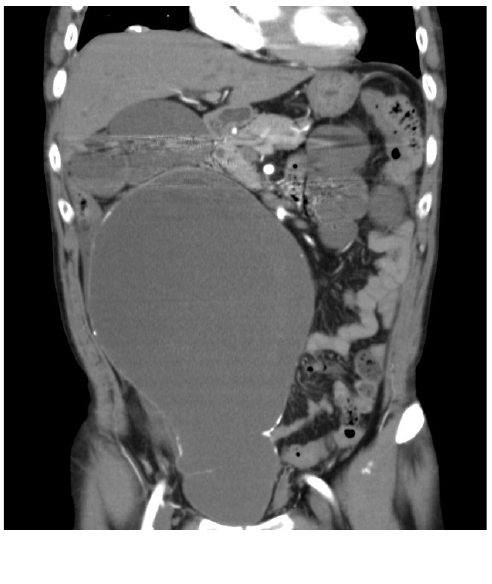
Figure 2 - Contrast-enhanced CT of the abdomen two years after embolization demonstrates, in comparison with Figure 1, that only the largest cyst had increased in size while the others had